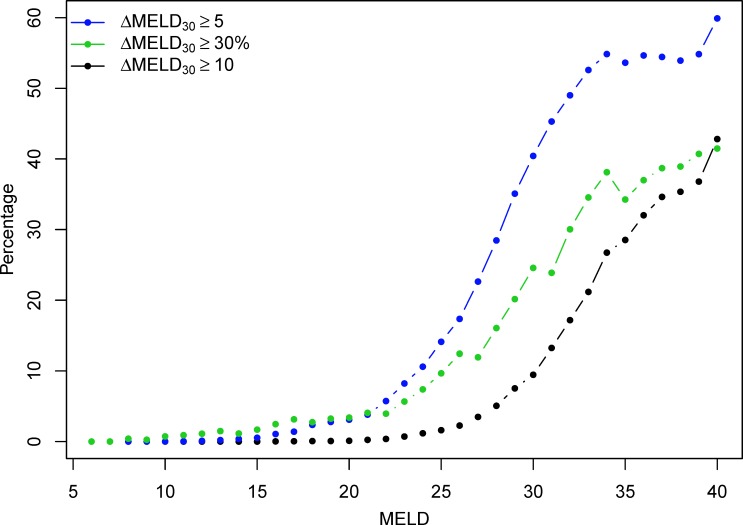
Percentage of observations with ΔMELD30 ≥ 10, ΔMELD30 ≥ 5, and ΔMELD30 of 30% or more at each MELD score.